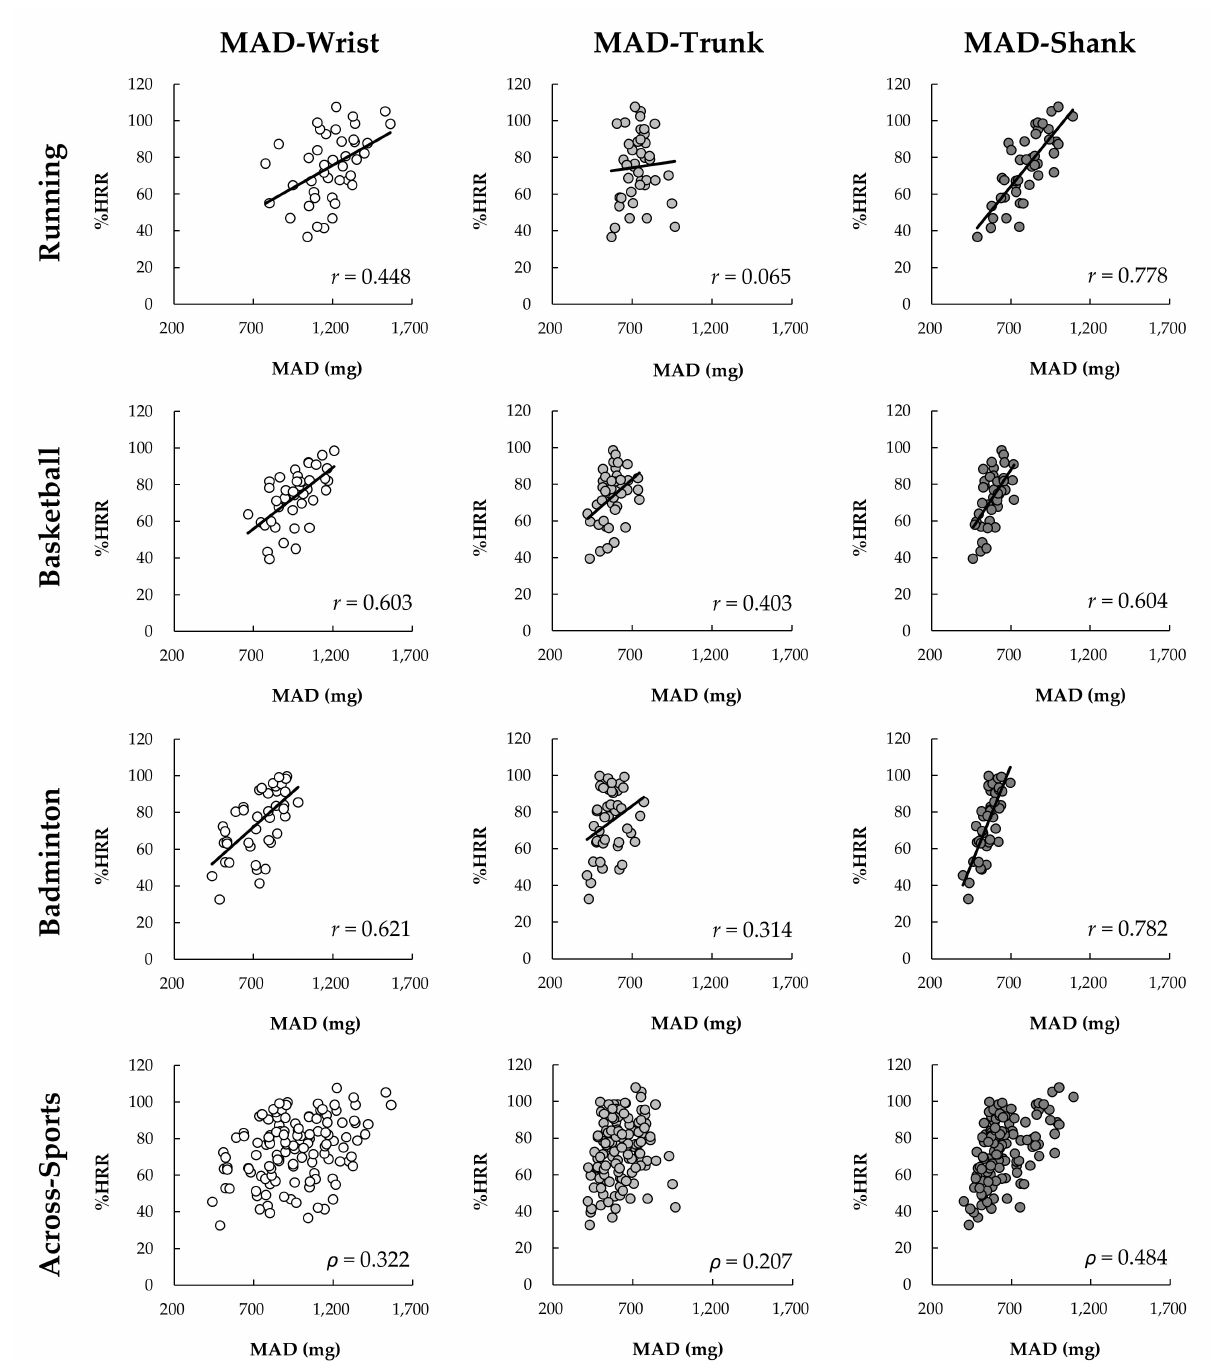
Figure 7. The within-sport Pearson ( r ) ( n = 42) and across-sports Spearman ( ρ ) ( n = 126) correlation coefficient for %HRR and